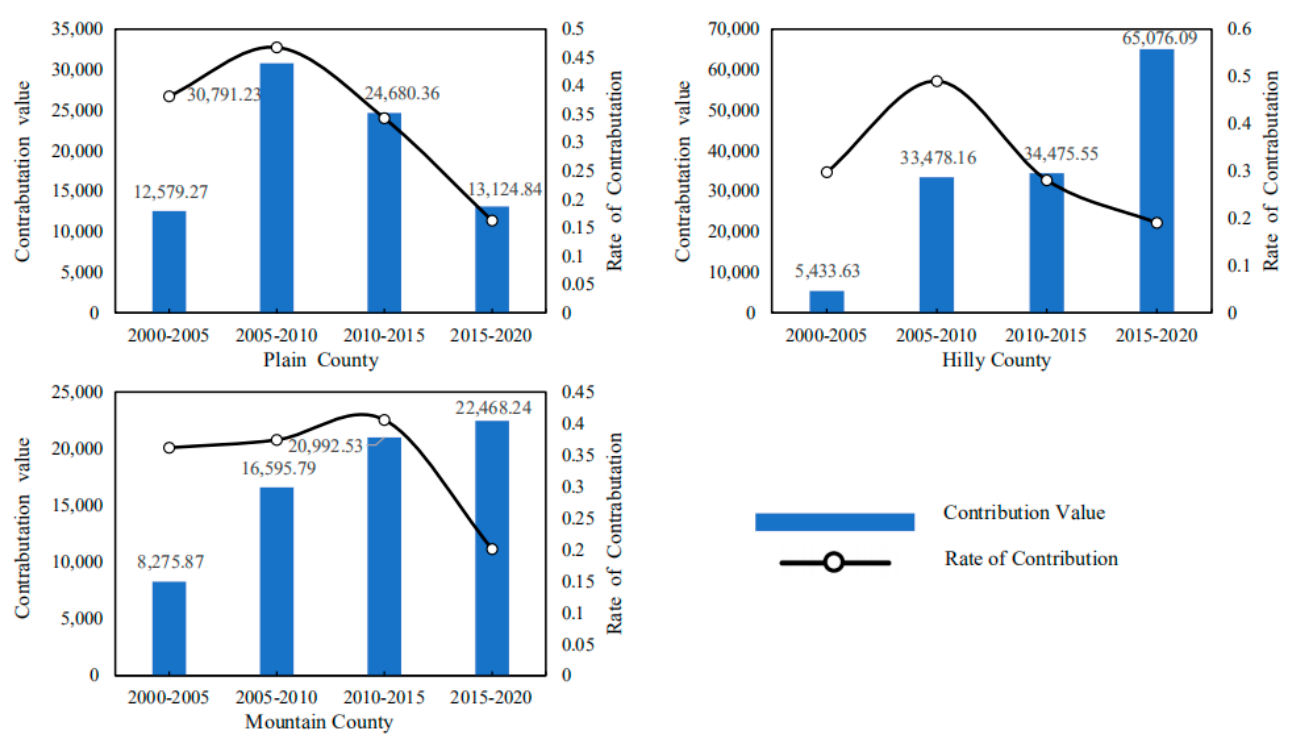
Figure 12. Topographic heterogeneity of emission reduction effect of agricultural production struc- ture (including Plain County, Hilly County, Mountain County).